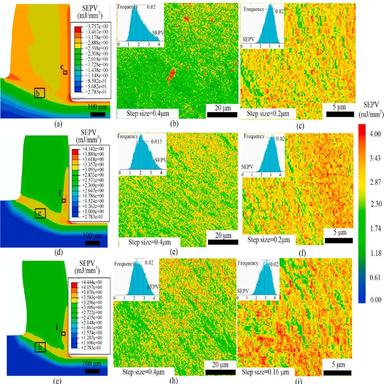
Simulation and experimental results of SEPV field in the cutting deformation zones. (a)–(c),(d)–(f),(g)–(i) successively present the results at 30 m/min, 90 m/min and 150 m/min (a),(d) and (g) are the simulation results. (b)–(c), (e)–(f) and (h)–(i) are the experimental results in the selected areas (black frames) in (a),(d) and (g), in which the sub-figures represent the frequency distribution of SEPV and the colour indicates the value of SEPV as shown in the legend at the right side of Fig. 12. (For inte